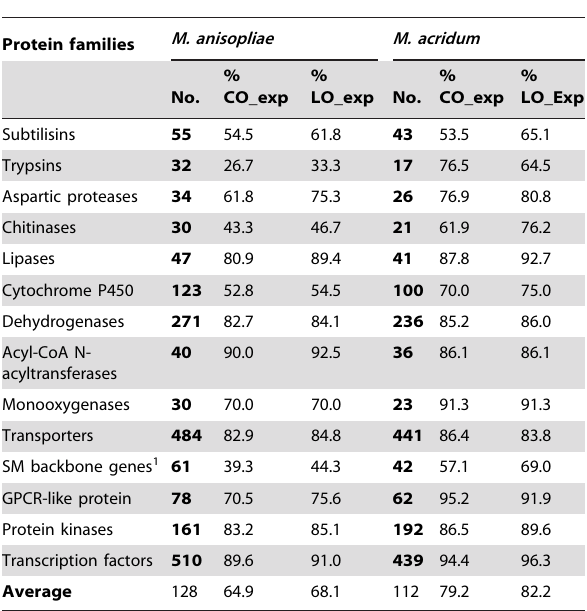
Table 2. Comparison of selected protein families in M. anisopliae and M. acridum and their percentage of expression on cockroach (CO) and locust (LO) cuticles during pre- penetration